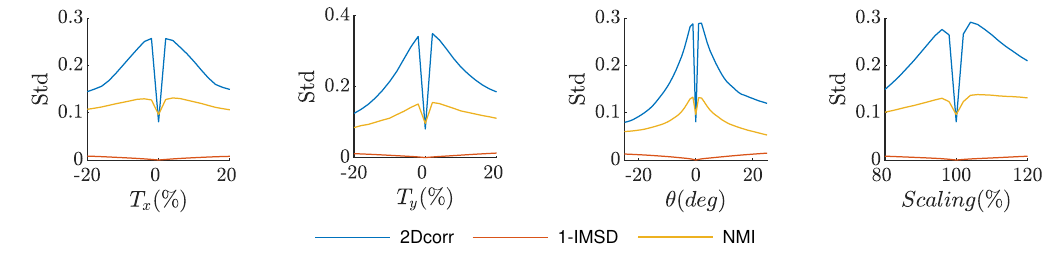
Figure 11. Metric value dispersion under real operation conditions, i.e., when each video frame is compared to the previous frame. Output standard deviation, computed along all studied video sequences, provides a quantitative assessment of how robust each metric is in front of natural image dissimilarities and recording